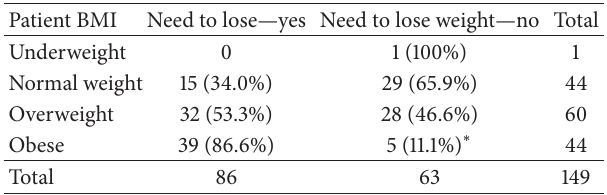
Table 1: Patients perceptions on whether they need to lose weight in relation to their actual